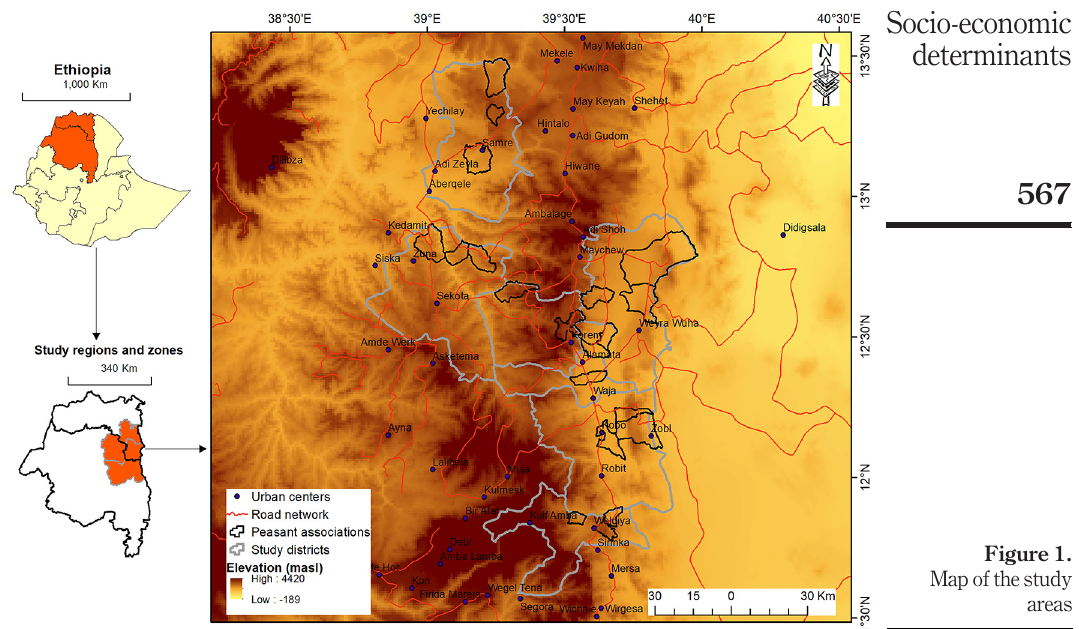
Figure 1. Map of the study